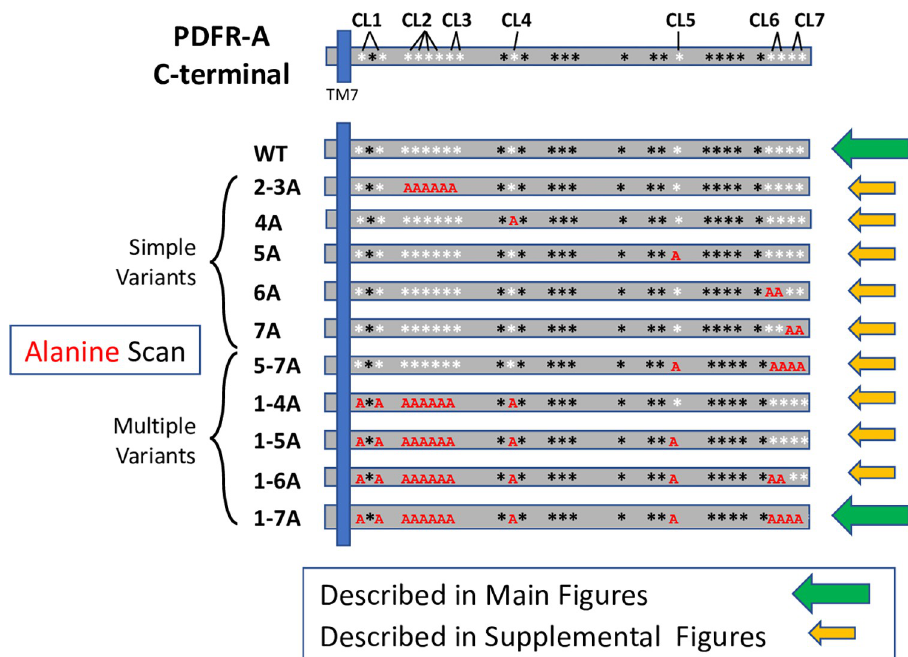
Fig 1. A map illustrating the series of PDFR sequence variants used to test a role for PDFR phosphorylation in regulating the locomotor rhythms. The C Terminal of the PDFR-A isoform is diagrammed (top) to the right of the 7 th transmembrane domain (TM7, blue). Asterisks indicate the positions of the 28 serine, threonine or tyrosine residues present within the PDFR C Terminal tail. The residues marked by the white asterisks were those chosen for study by sequence alteration to encode Alanine; they were given arbitrary designations as Clusters (CL) 1 through 7. Each cluster contains a single residue (e.g., CL4 or CL5), or as many as four residues (e.g., CL2). The ten sequence variants are named by the Cluster(s) that was altered followed by the letter ‘A”. Simple Variants include those wherein residues in one or two Clusters were altered. Multiple Variants include those wherein residues within three or more Clusters were altered. All 14 targeted residues were altered in the PDFR 1-7A variant. The green arrows mark the WT and 1-7A PDFR variant: their behavioral effects are featured in the Main Figures. The yellow arrows mark the nine other PDFR variants: their behavioral effects are described in S2 Fig, S3 Fig, S4 Fig, S5 Fig, S6 Fig and S7 Fig .